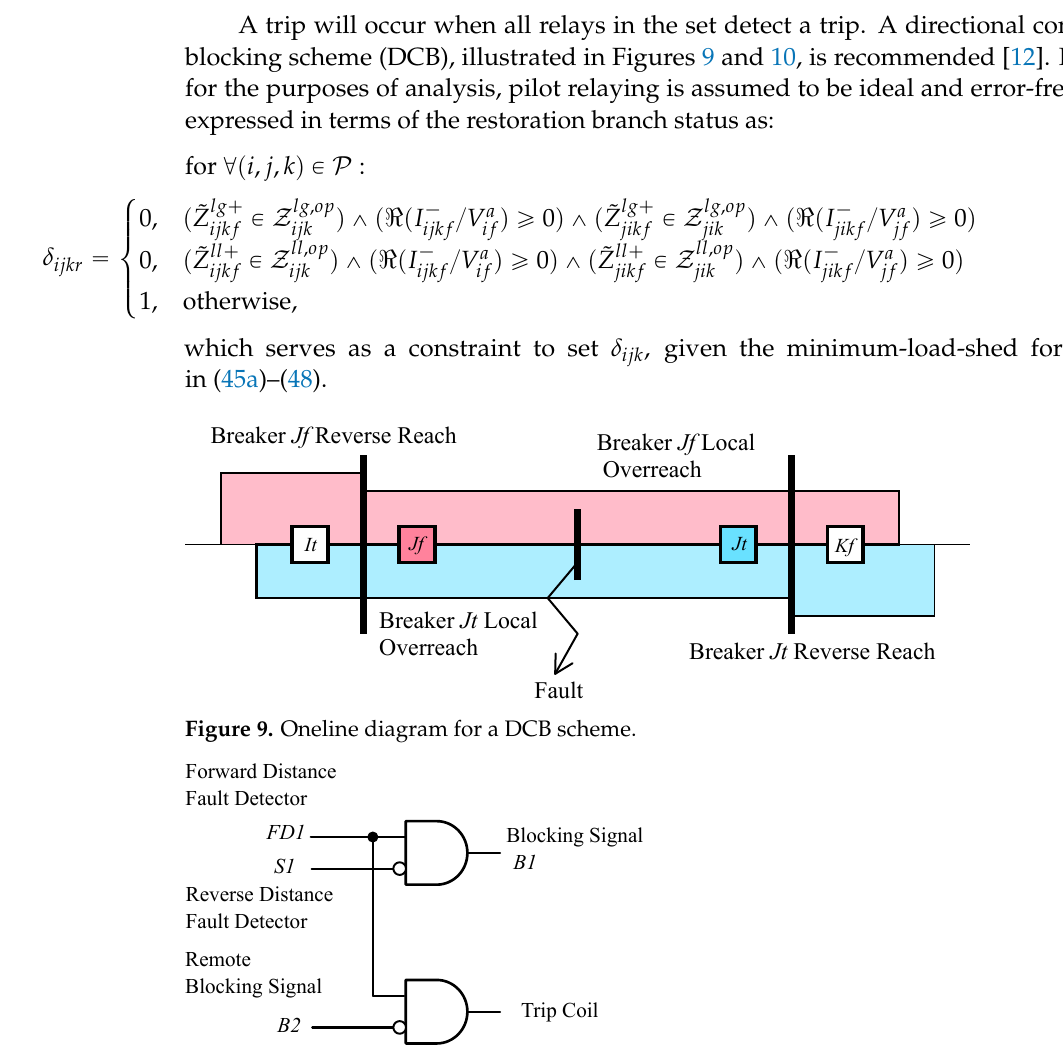
Figure 10. Schematic for one relay in a directional comparison blocking (DCB)